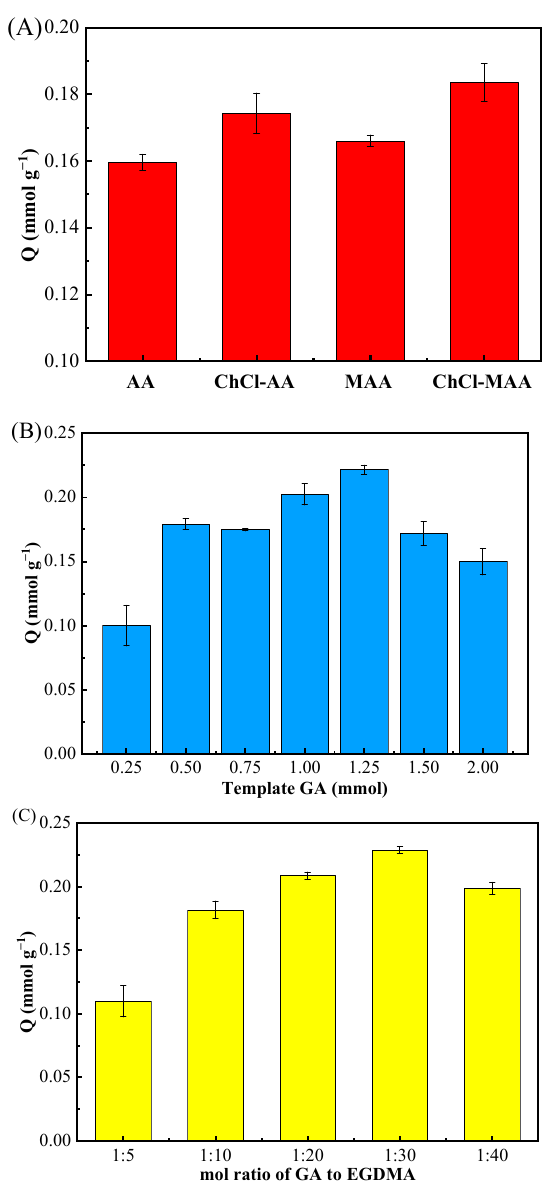
Figure 2. Effect of different functional monomers (AA, ChCl-AA, MAA, ChCl-MAA) ( A ), amount of template GA (0.25, 0.50, 0.75, 1.00, 1.25, 1.50, 2.00 mmol) ( B ), and molar ratio of the template GA to cross-linker EGDMA (1:5, 1:10, 1:20, 1:30, 1:40) ( C ) on MIPs’ adsorption for GA.